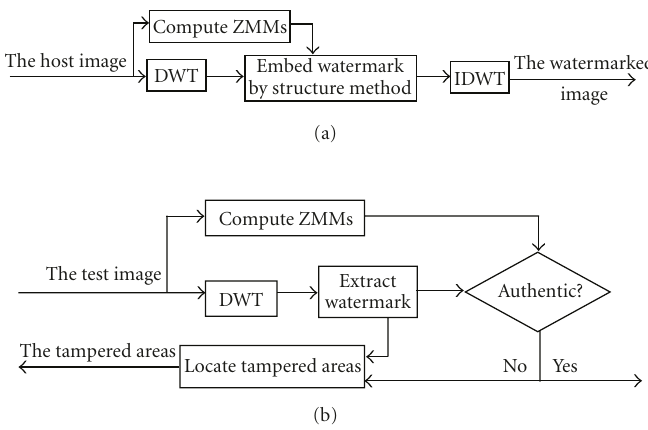
Figure 6: The framework of the proposed scheme: (a) embedding process (b) authentication process.